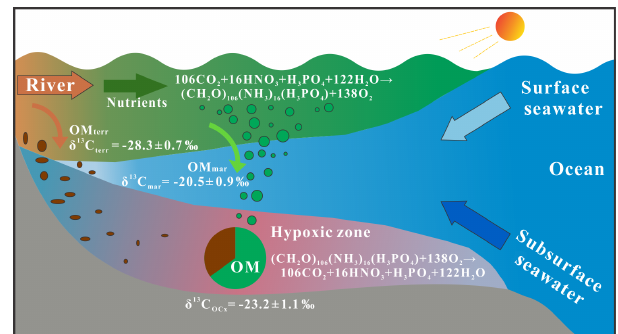
Figure 9. A conceptual diagram illustrating the partitioning of oxygen-consuming organic matter (OC mar vs. OC terr ) within the hypoxic zone in the lower PRE and the adjacent coastal area. See Sect. 5 for